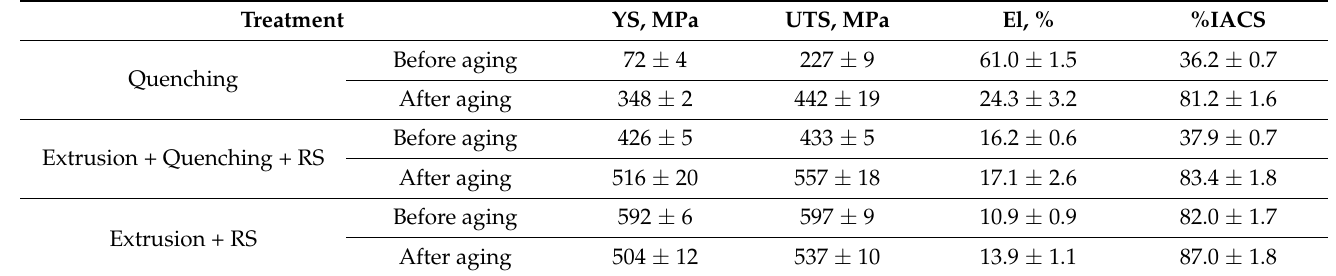
Table 1. Mechanical properties and electrical conductivity (%IACS) of the Cu-0.5%Cr-0.08%Zr alloy in various microstructural